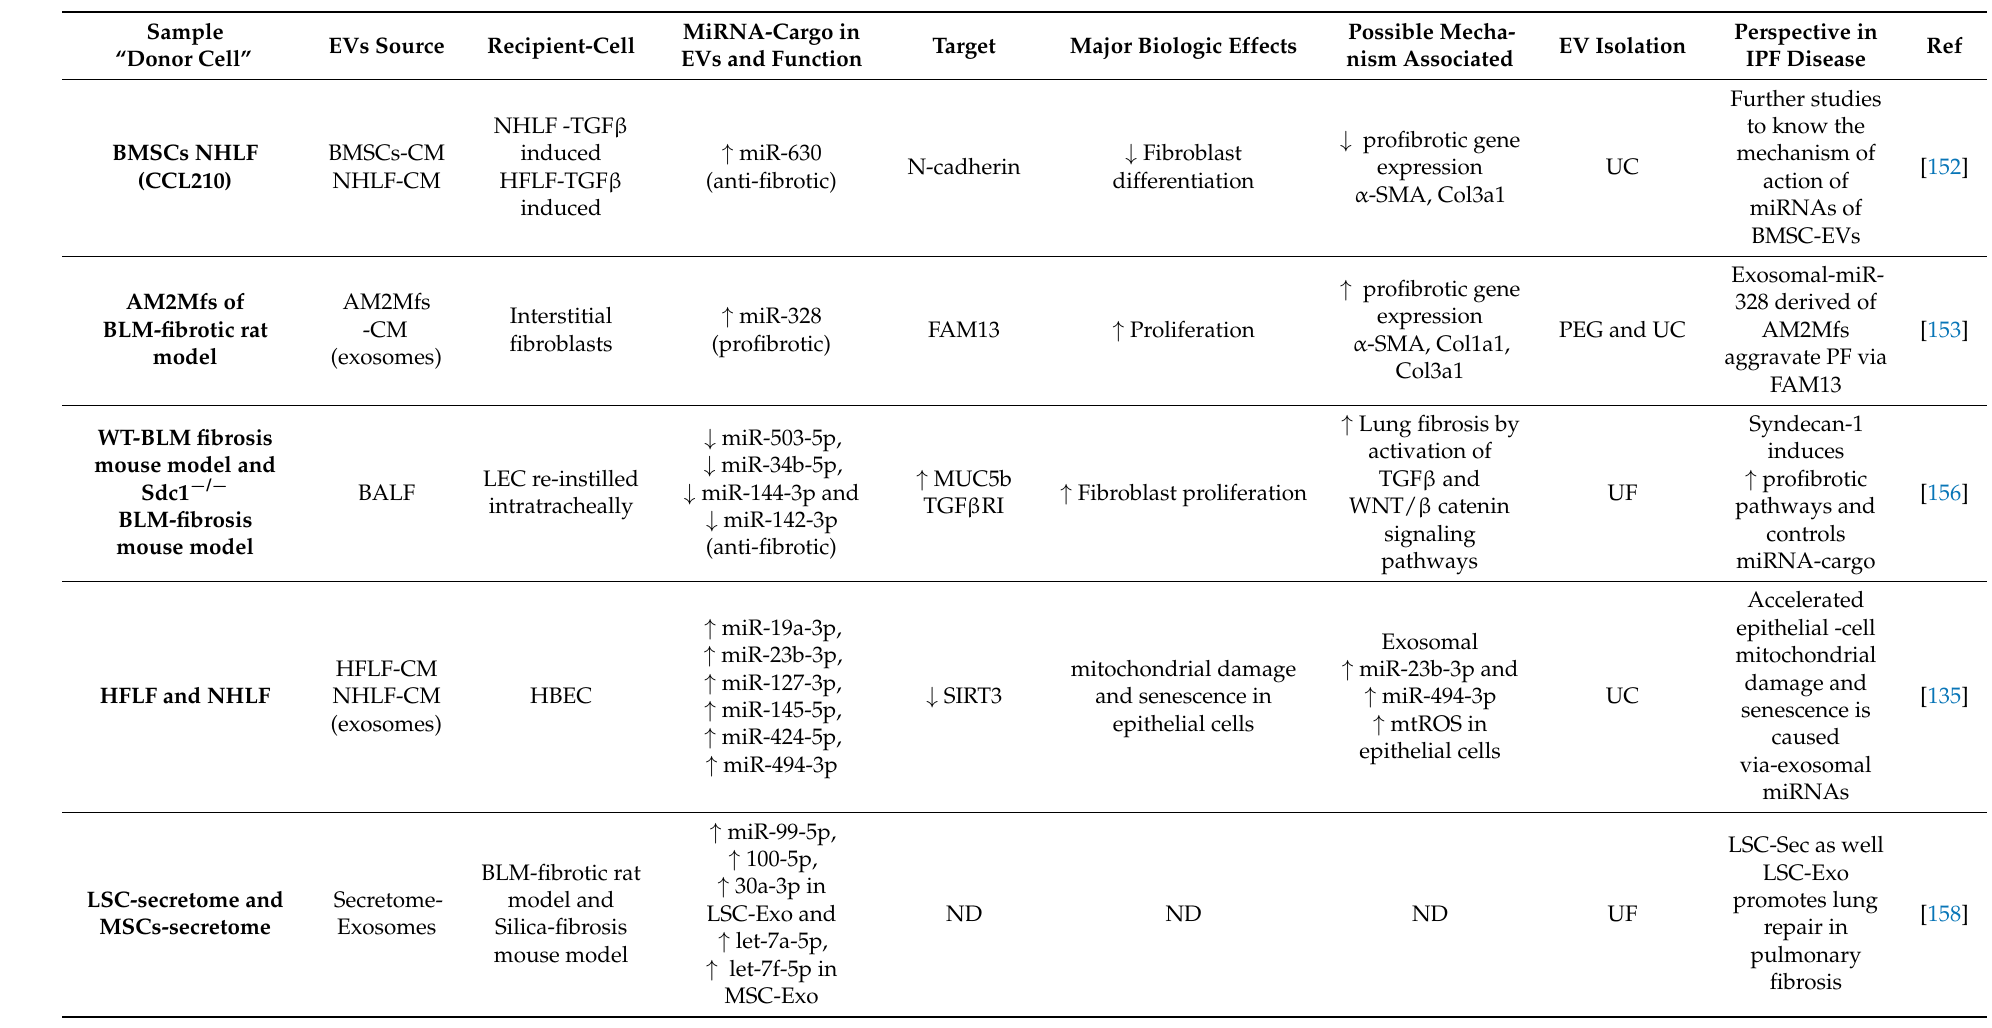
Table 1. Exosomal miRNAs and their effects in IPF